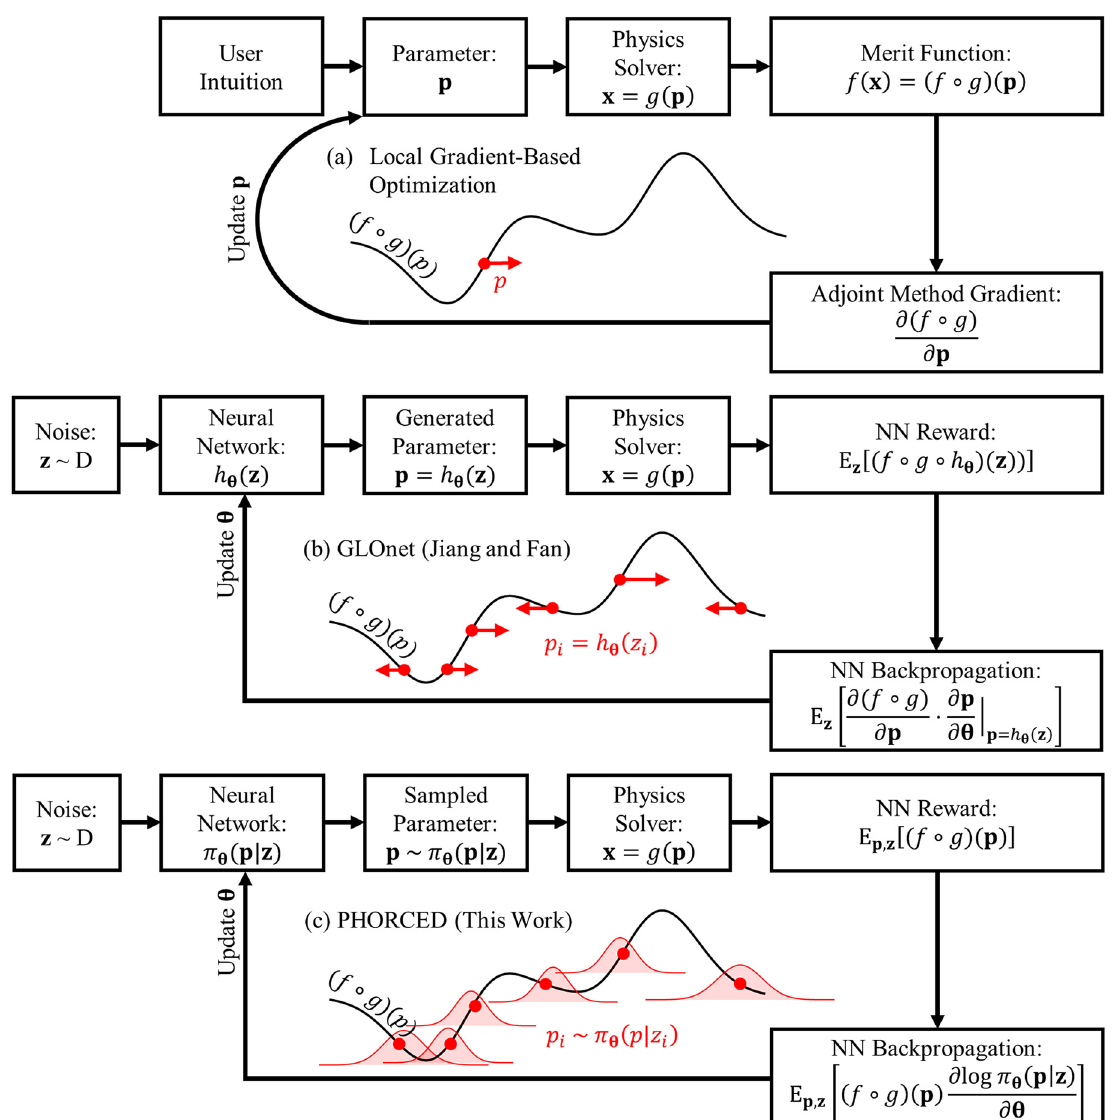
Figure 1: Neural networks provide a natural extension to conventional inverse design via the adjoint method. A typical gradient-based design loop is shown in (a) where the derivatives are calculated using the adjoint method. The GLOnet method (b), originally proposed by Jiang and Fan [ 24 , 25 ], replaces a conventional gradient-based optimization algorithm with a deterministic neural network. In this work we propose PHORCED (c), which uses a probabilistic neural network to generate devices. (b) and (c) are qualitatively similar, but require different gradients in backpropagation because of the representation of the neural network (deterministic versus probabilistic). In particular, notice that PHORCED does not require an evaluation of the adjoint method gradient of the electromagnetic merit function, 𝜕 ( f ⚬ g ) 𝜕 p